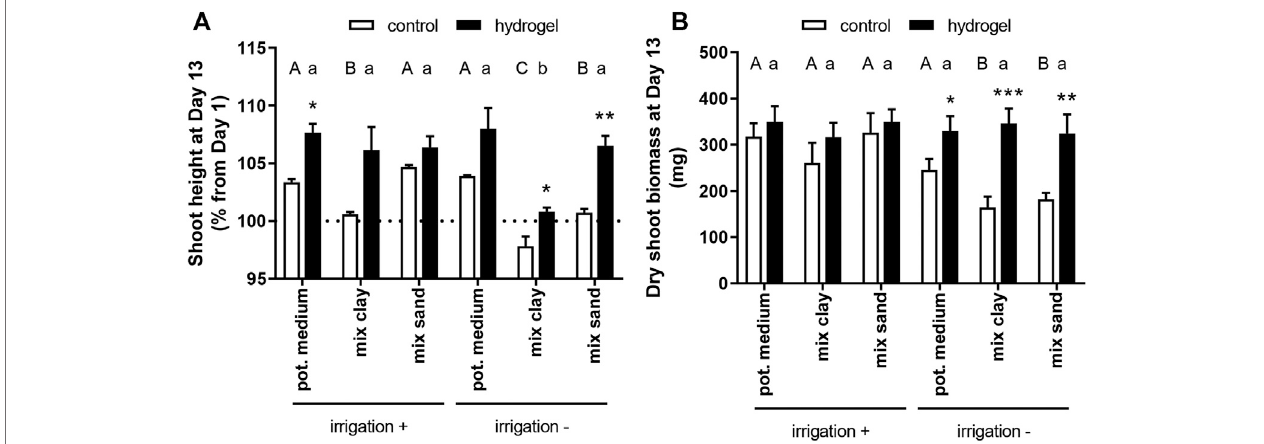
FIGURE 2 | Shoots heights (A) and dry shoots biomasses (B) of spearmint ( Mentha spicata ) 13 days after transplantation (Day 13), with (hydrogel) or without (control)0.1%(w/w)hydrogelsupplementation,undervaryingirrigationconditions. Potswere fi lledwithsoilsfrom MDRSlocation(see Table1 )supplementedwith10% (w/w) potting medium or with potting medium alone (mix clay, mix sand and pot. medium, respectively). Plants were either daily watered (irrigation +) or each 4 days (irrigation – ). All data are means of three replications. Statistical analysis for comparison between control and hydrogel conditions: unpaired Student ’ s t-test. * p < 0.05, ** p < 0.01, *** p < 0.001. For comparison between soils: one-way ANOVA with Tukey ’ s post hoc test. Different uppercase (control) or lowercase (hydrogel) letters indicate values signi fi cantly different from each other.